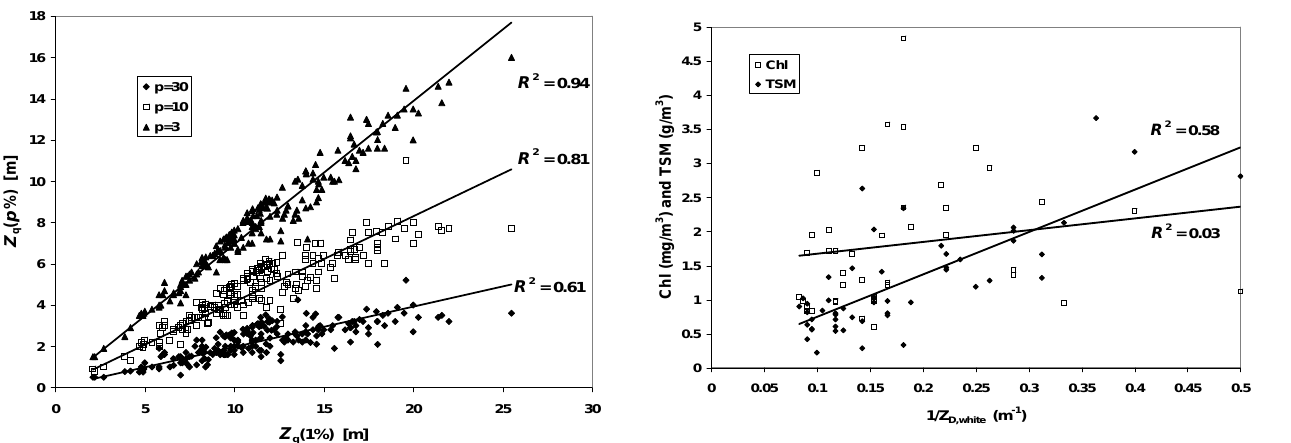
00.511.522.533.544.55 0 0.05 Fig. 10. Content of Chl and TSM versus 1 /Z D,white at stations north of 57 ◦ N. The best-fit lines are Chl = [1.50mgm − 3 ] + [1.73mgm − 2 ] /Z D,white and TSM = [0.12gm − 3 ] + [6.22gm − 2 ] /Z D,white